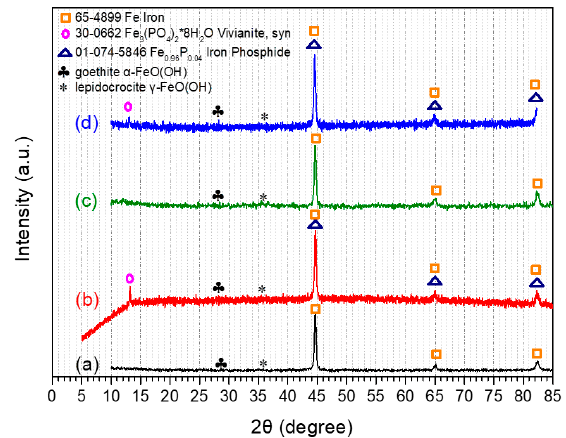
Figure 13. XRD spectra of the mild steel panels after submission in WSS for 96 h: ( a ) Steel–WSS–blank , ( b ) Steel–WSS–Na 2 HPO 4 , ( c ) Steel–WSS–MBT , ( d ) Steel–WSS–Na 2 HPO 4 –MBT .